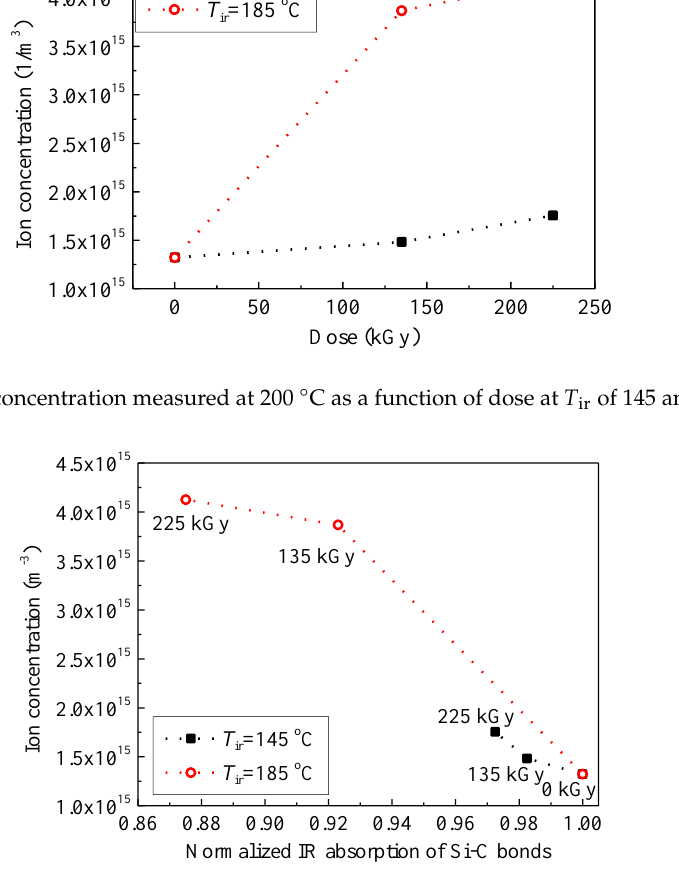
Figure 11. Ion concentration measured at 200 °C as a function of normalized absorption intensity of Si–C bonds observed at 785 cm −1 at T ir of 145 and 185 °C.